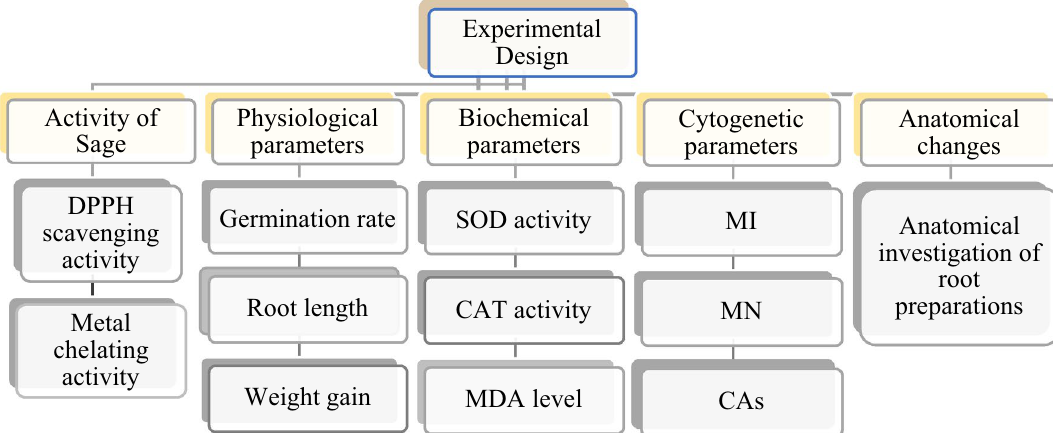
Figure 1. Experimental stages of study. DPPH 2,2-diphenyl-1-picrylhydrazyl, SOD superoxide dismutase, CAT catalase, MDA malondialdehyde, MI mitotic index, MN micronucleus, CAs chromosomal